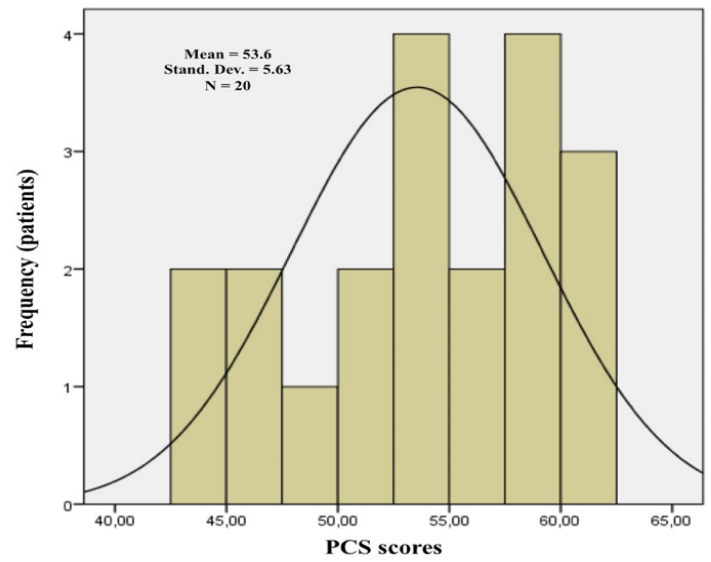
Figure 1. Physical Component Summary (PCS) histogram (created by SPSS software for Windows, release 20.0).